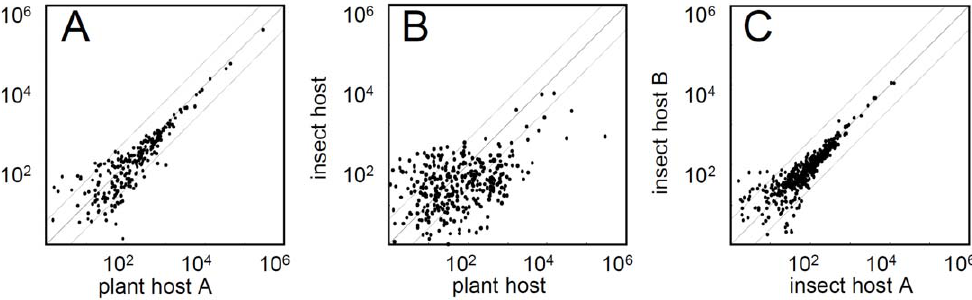
Figure 3. Comparison of signal intensities for phytoplasmas in plant and insect hosts. (A) Correlation between the gene expression levels of OY-M grown in plant hosts obtained from the experiment of Fig. 2A. The average intensities of two independent plants (plant host A) and the average intensities of rest two independent plants (plant host B) are plotted. (B) Correlation between the gene expression levels of OY-M grown in the plant and insect hosts. The average intensities of four independent experiments are plotted. (C) Correlation between the gene expression levels of OY-M grown in insect hosts. The average intensities of two independent insects (insect host A) and the average intensities of rest two independent insect (insect host B) are plotted. The dotted lines represent expression data within a 4-fold rate. Since almost all signals of ‘‘not infected’’ are zero (please see Figure S2), the plot of ‘‘infected’’ vs. ‘‘not infected’’ in the same host is not presented in this figure.